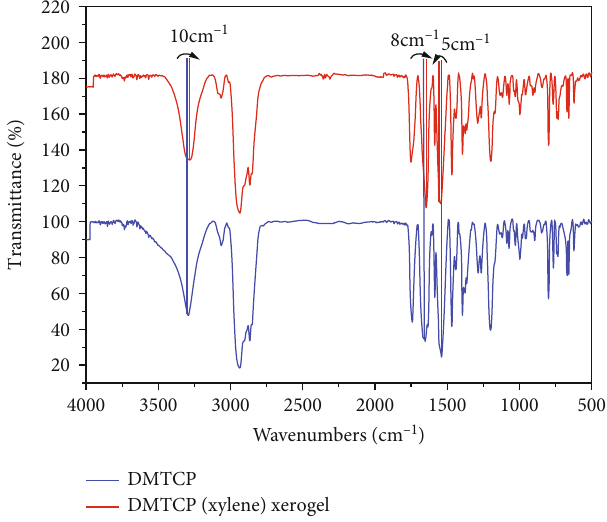
Figure 9: Infrared comparison between DMTCP(CCl and DMTCP.